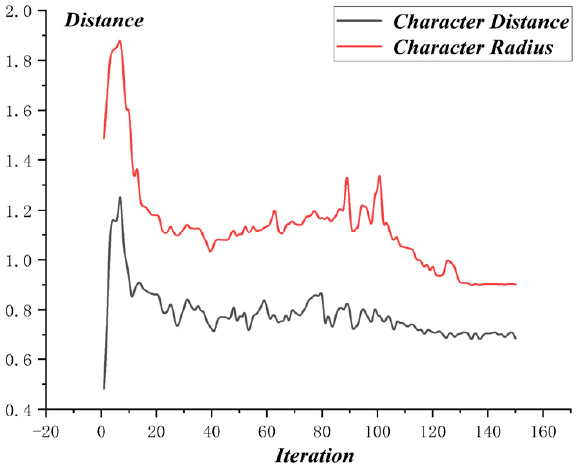
Figure 14. Optimization process of MO-GWO.